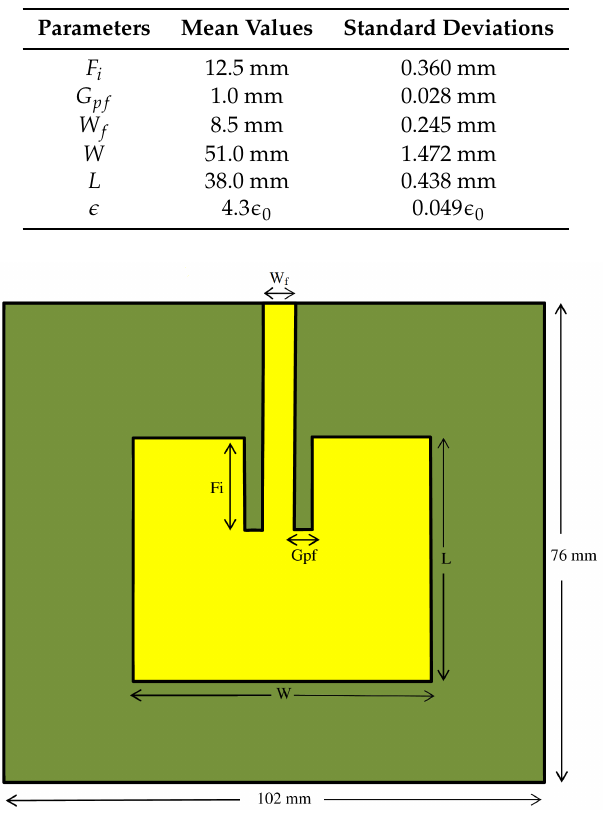
Figure 8. Schematic of the patch-antenna